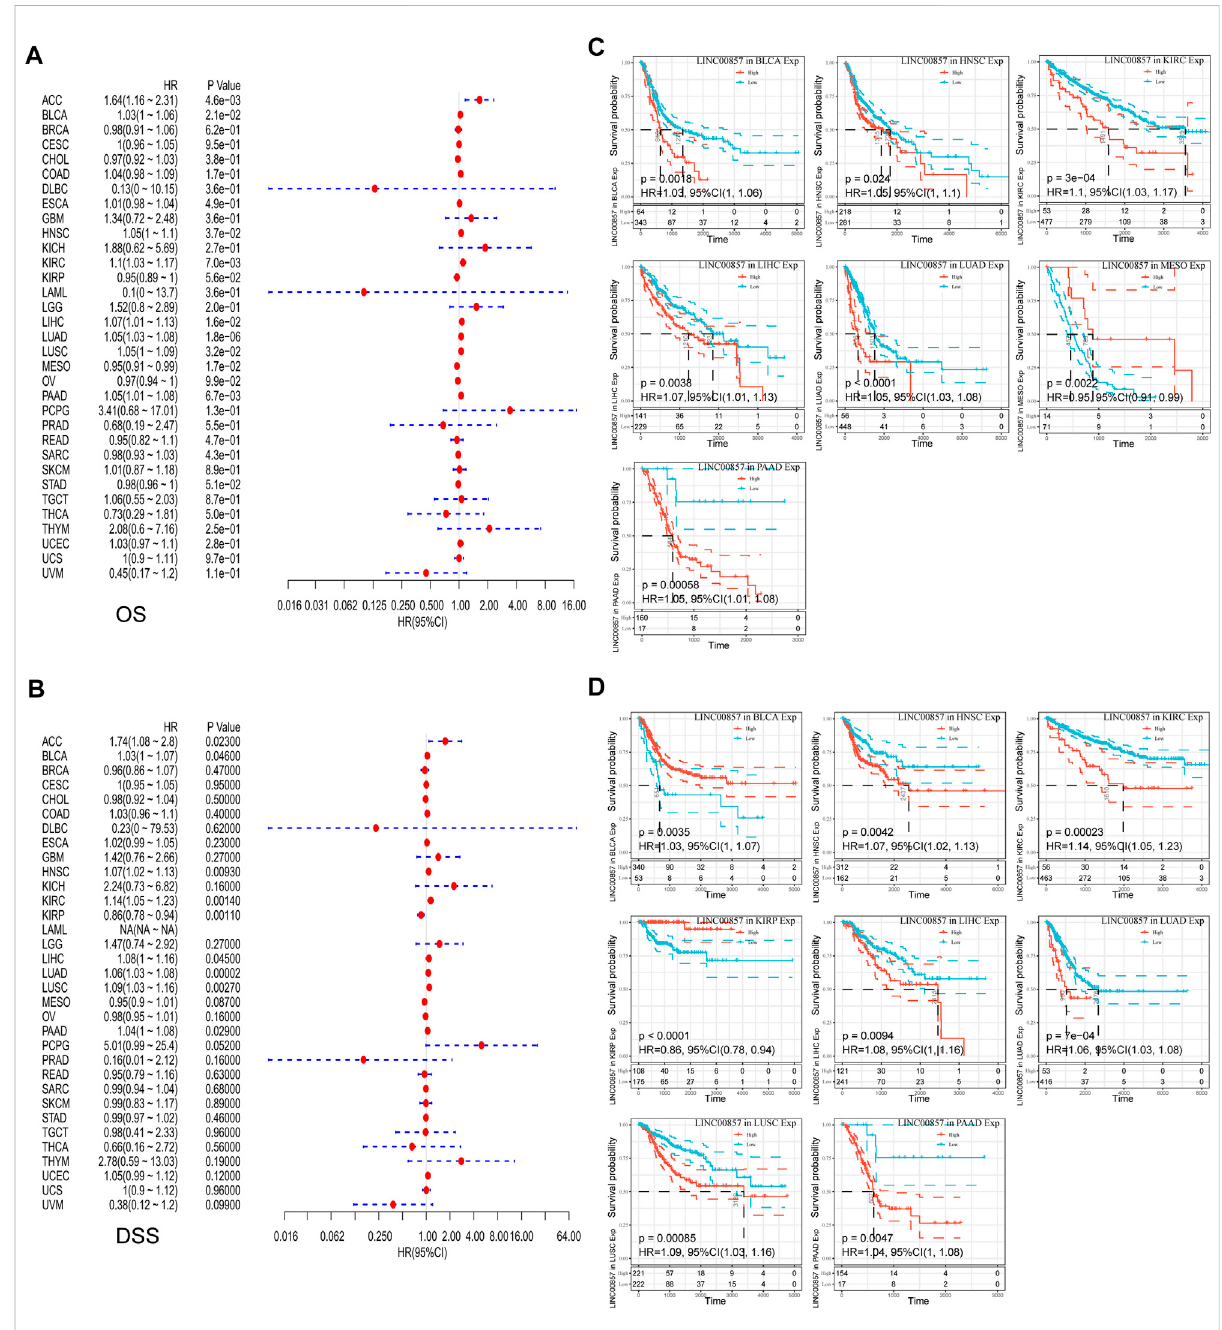
The correlationbetweenLINC00857 expression and OSand DSSinpan-cancer. (A,B) Cox regression analysis ofLINC00857 onOS andDSSfor multiple neoplasms was depicted via forest diagrams. (C,D) Kaplan-Meier curves presented OS or DSS for patients with high and low LINCOO857 expression ( p <